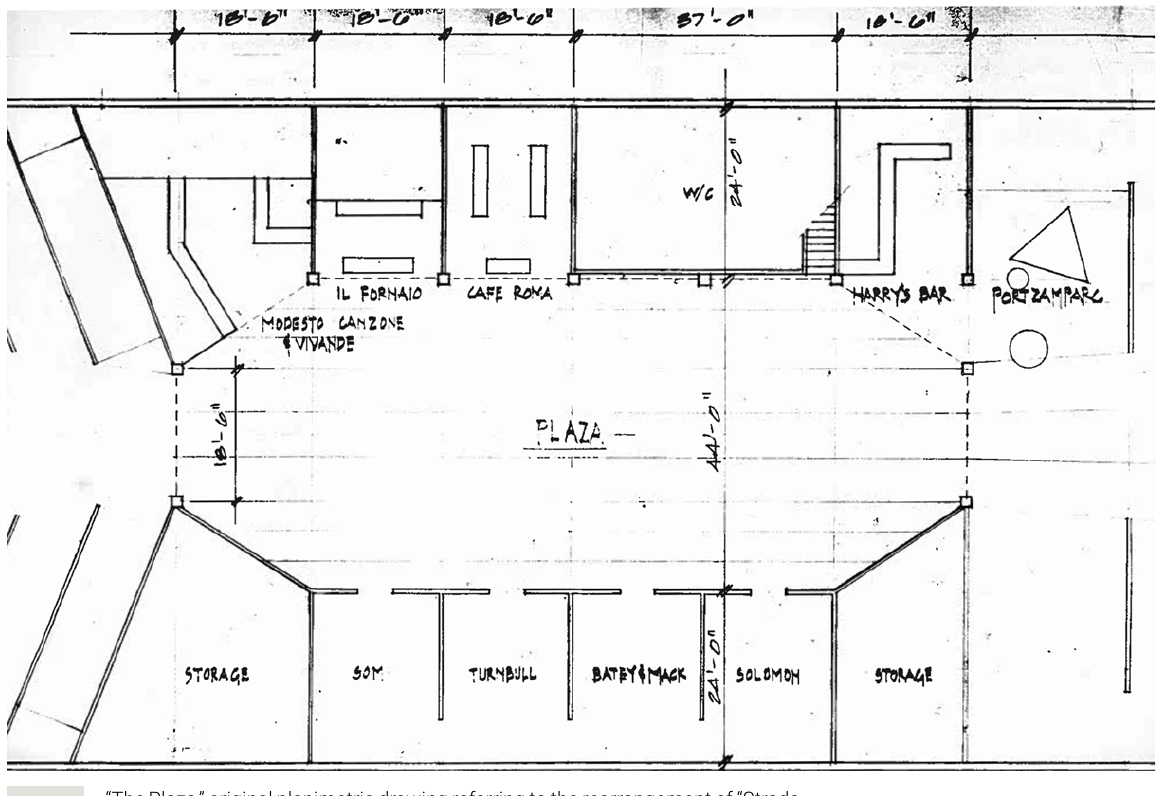
FIG. 9 “The Plaza,” original planimetric drawing referring to the rearrangement of “Strada novissima” for “The Presence of the Past” exhibition held in San Francisco